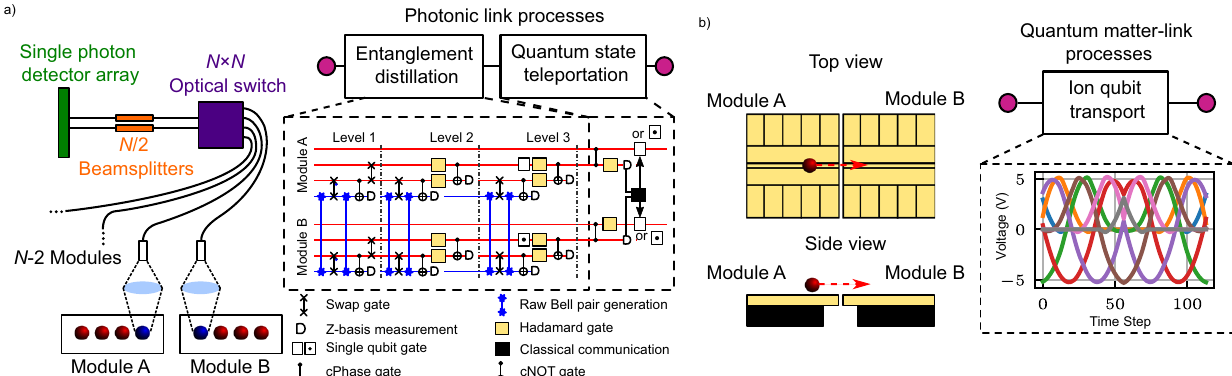
Fig. 1 | An illustration of the process for connecting two modules (Module A and Module B) for the purposes of a modular ion-trap QC. a Photonic links use probabilistic, heraldedentanglement which isgenerated from the interferenceof emitted photons from each module. The red and blue spheres denote different ion species. An N × N optical switch links the modules, where N is the number of modules. The emitted photons interfere at the beam splitter and a single photon detector array is used to herald the generation of entanglement between mod- ules. In order to generate a high- fi delity link between modules a distillation processisrequired.Thedashedboxrepresentsaproposalfora3-leveldistillation process that would take a 94% entanglement fi delity to 99.7% fi delity, more details can be found in Ref. 48 . After distillation, quantum teleportation can then